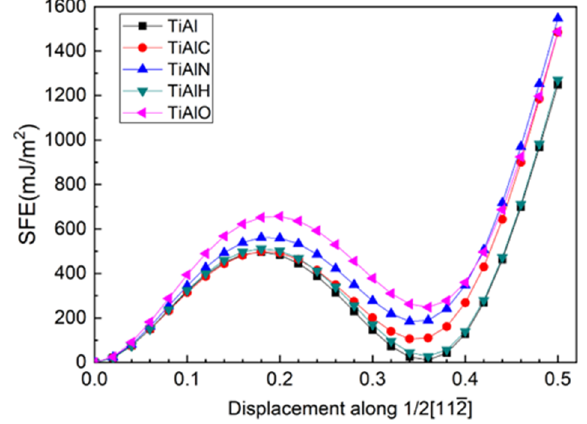
Table 3. Unstable stacking fault energy (USFE) and intrinsic stacking fault energy (ISFE) of twin model.